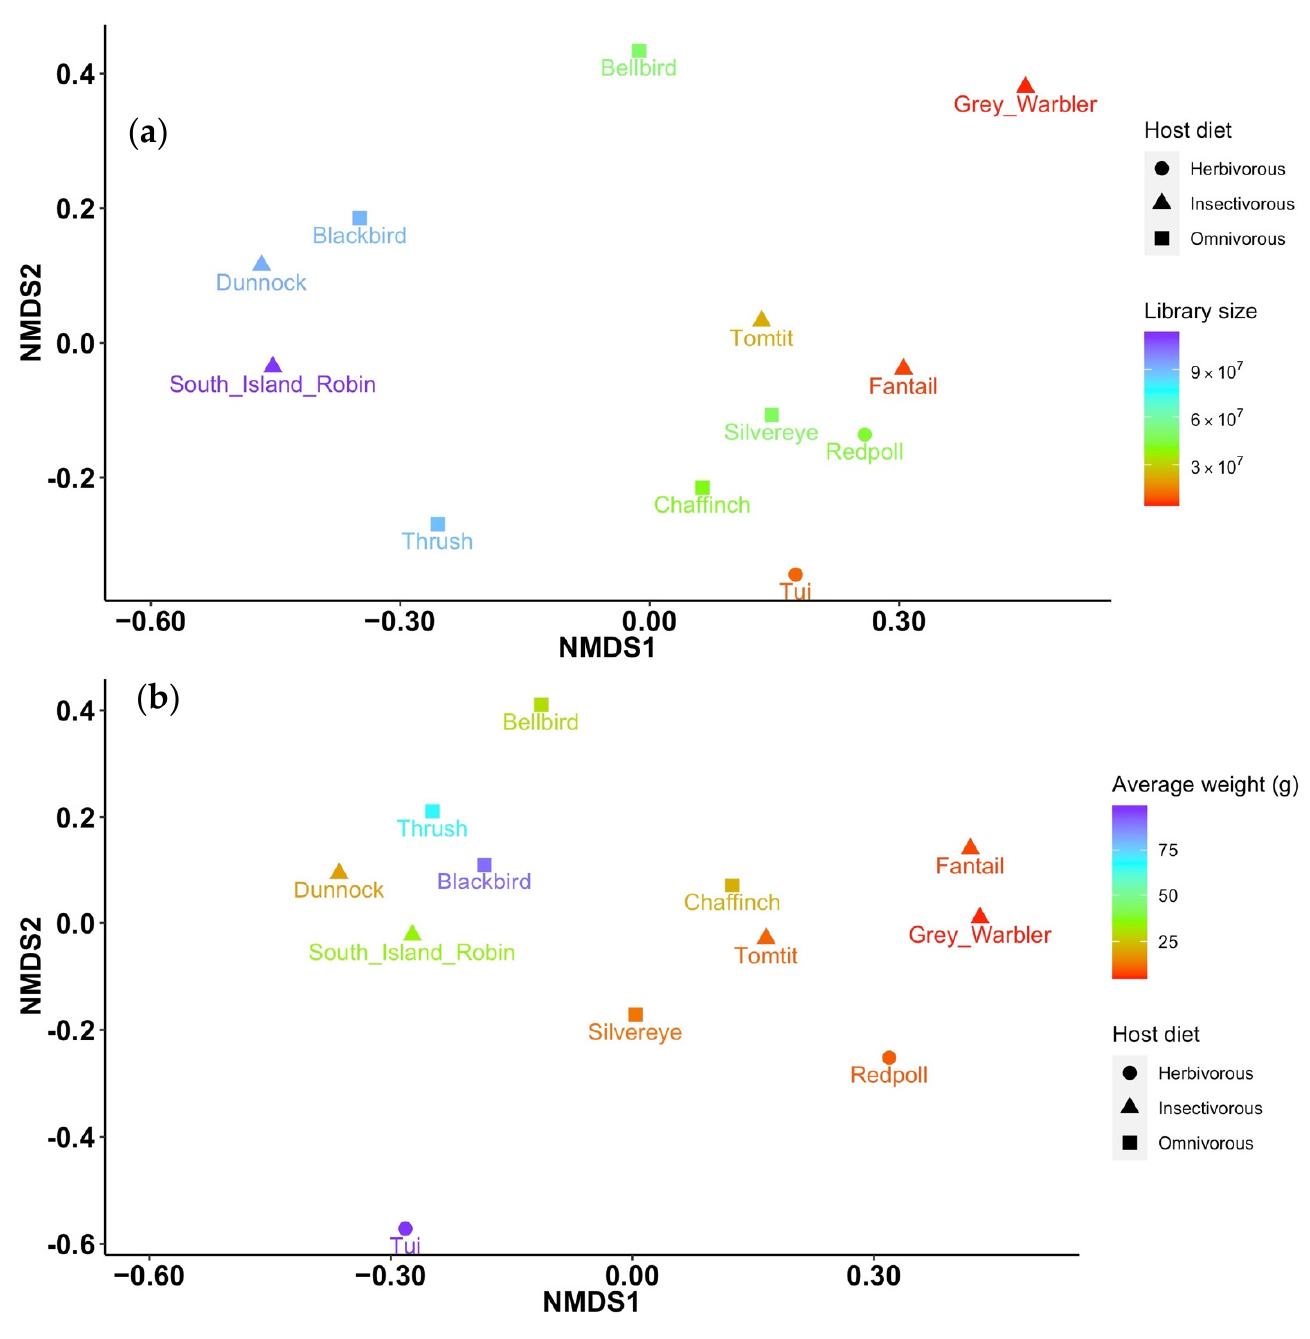
Figure 4. Non-metric multi-dimensional scaling plots applying the Bray–Curtis dissimilarity matrix for viral abundance and diversity, showing ( a ) the relative similarity/differences in the viral community at the virus species level in each host species (stress = 0.13), with the total number of reads for each library shown using the colour gradient and the host diet indicated using symbols, and ( b ) the relative similarity/differences in the viral community at the virus genus level in each host species (stress = 0.09), with the average weight in grams of the host species shown using the colour gradient and the host diet shown using symbols.